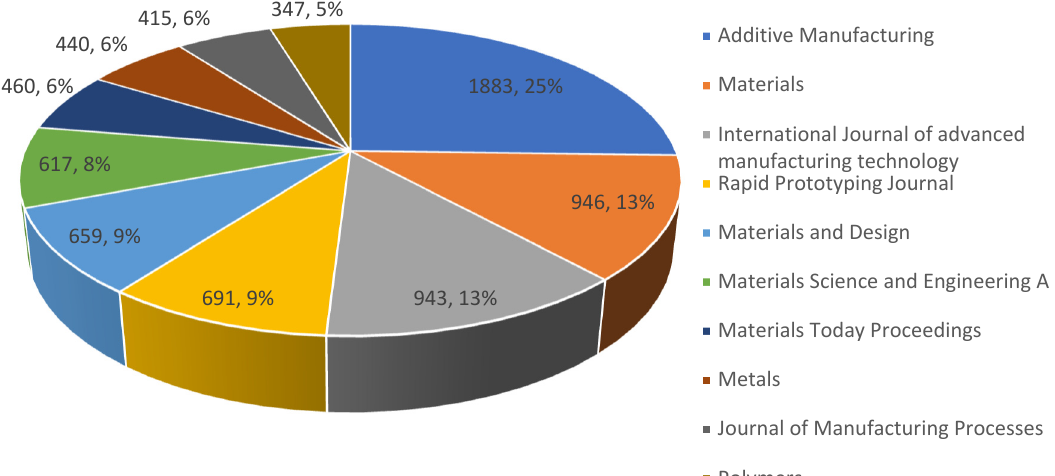
Figure 7. The total number of publications per year by source against percentage of publications from 2001 to 2022 (data retrieved from the Scopus database on 20 June 2022). Note: Each segment shows the number of publications and the corresponding percentages, which is separated by a comma (,) for each publication source.